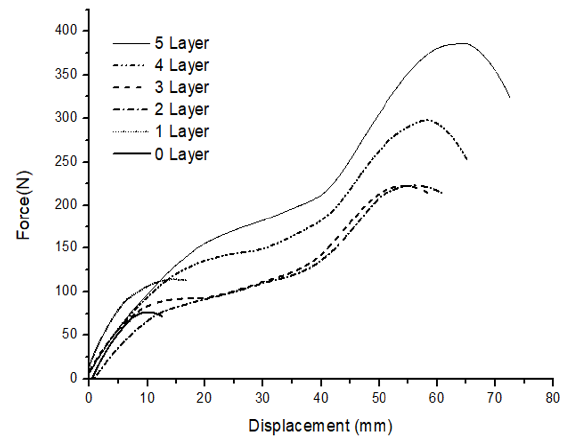
Fig. 6. Force-Displacement of Core by Layer